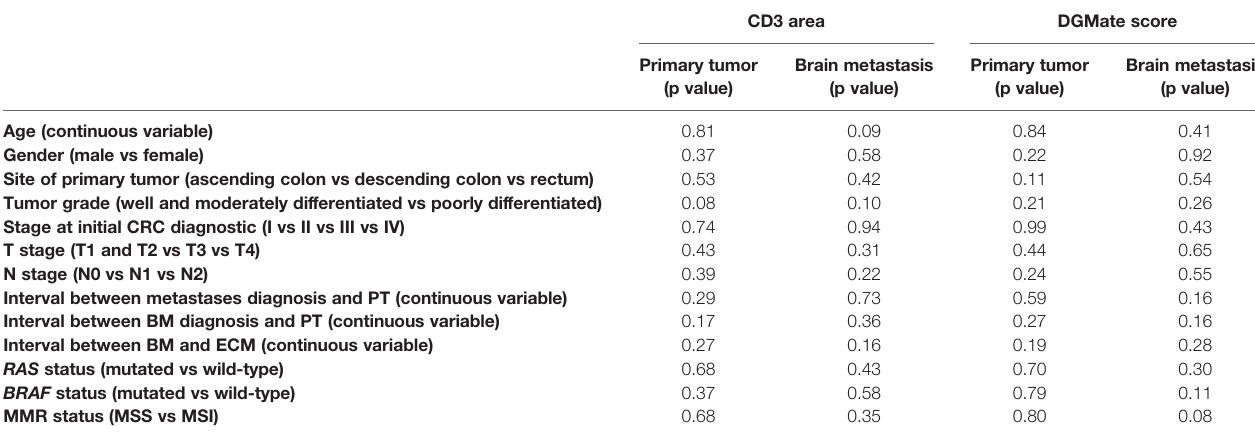
TABLE 2 | Correlation between CD3 T-cell in fi ltration and DGMate score with patient and tumor